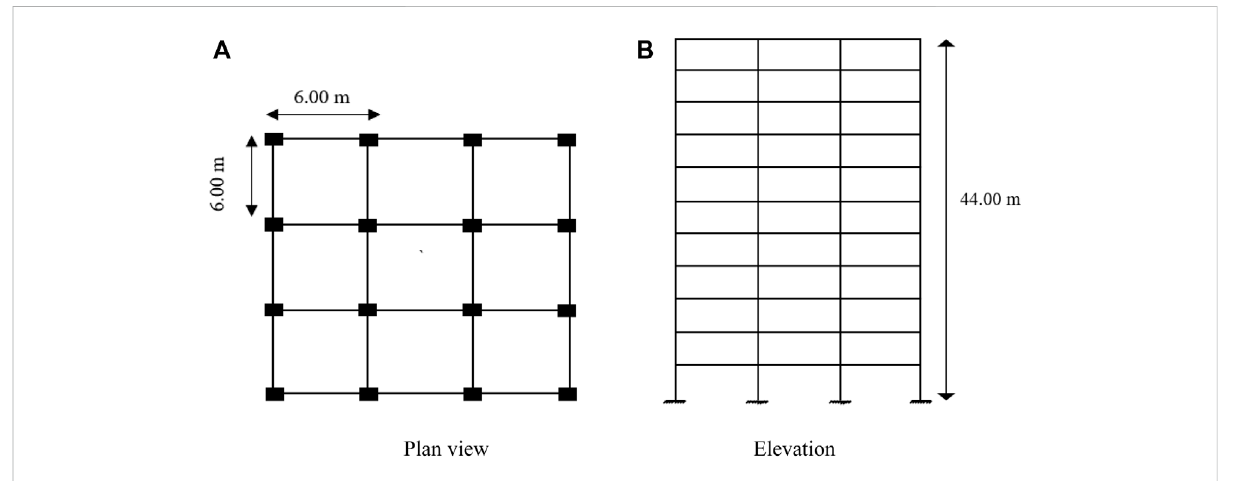
FIGURE 1 Plan and elevation view of the building. (A) Plan view. (B)